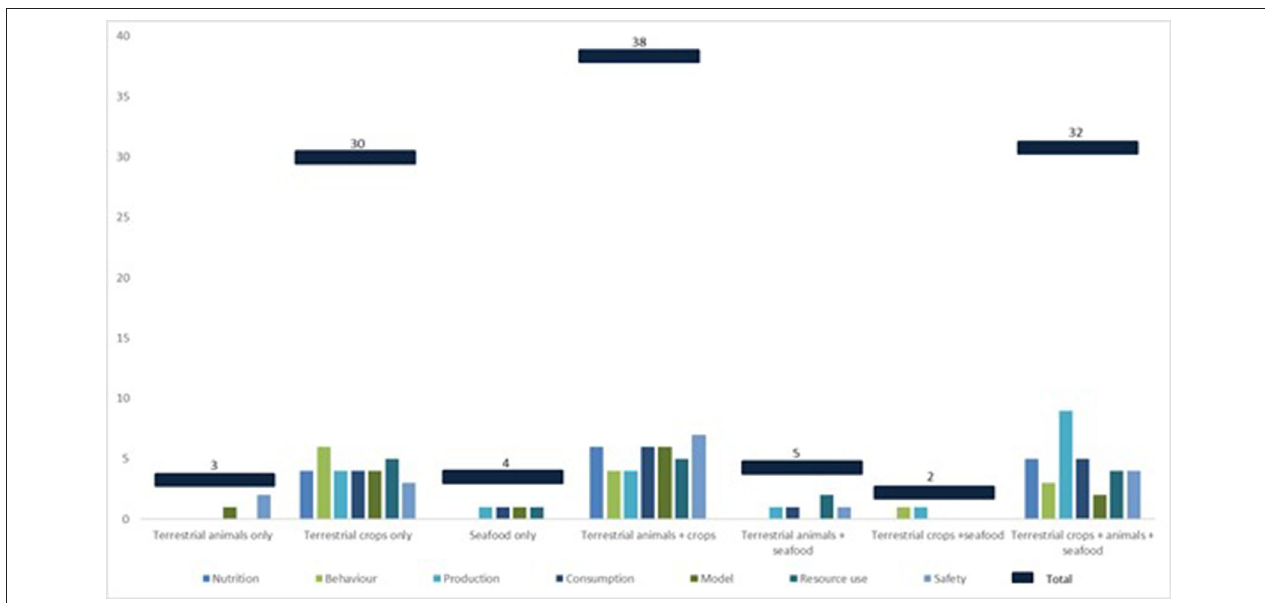
FIGURE 3 | Number of papers mentioning each food category and/or combination of food categories five or more times. Duplicated papers, those which appeared in multiple themes’ literature reviews, are counted only once. Total refers to the total number of papers mentioning each food category and/or combination five or more